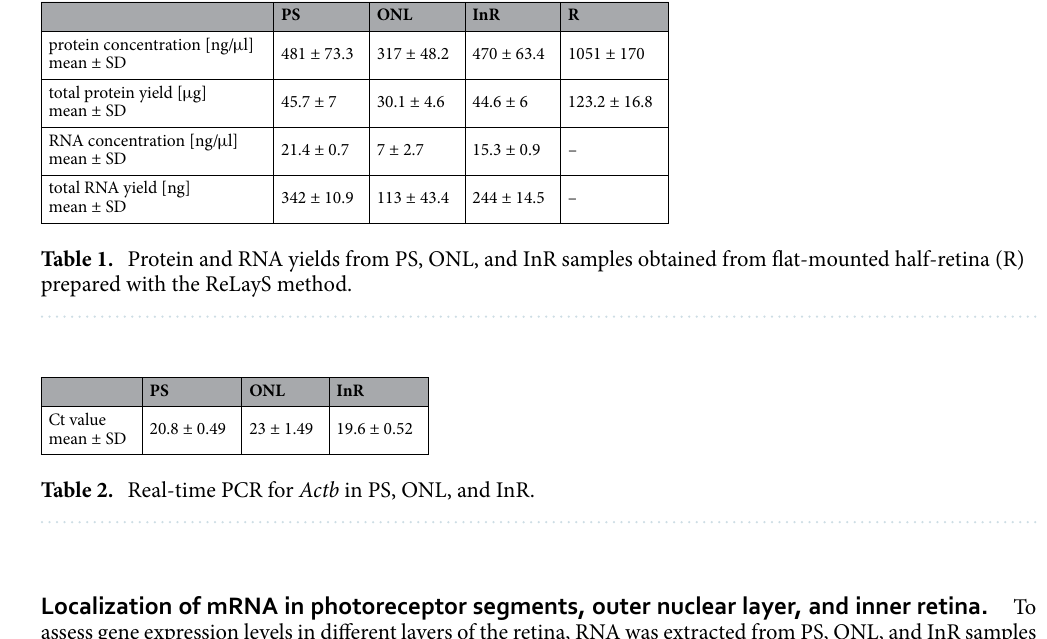
PS ONL InR R protein concentration [ng/ µ l] mean ± SD 481 ± 73.3 317 ± 48.2 470 ± 63.4 1051 ± 170 total protein yield [ µ g] mean ± SD